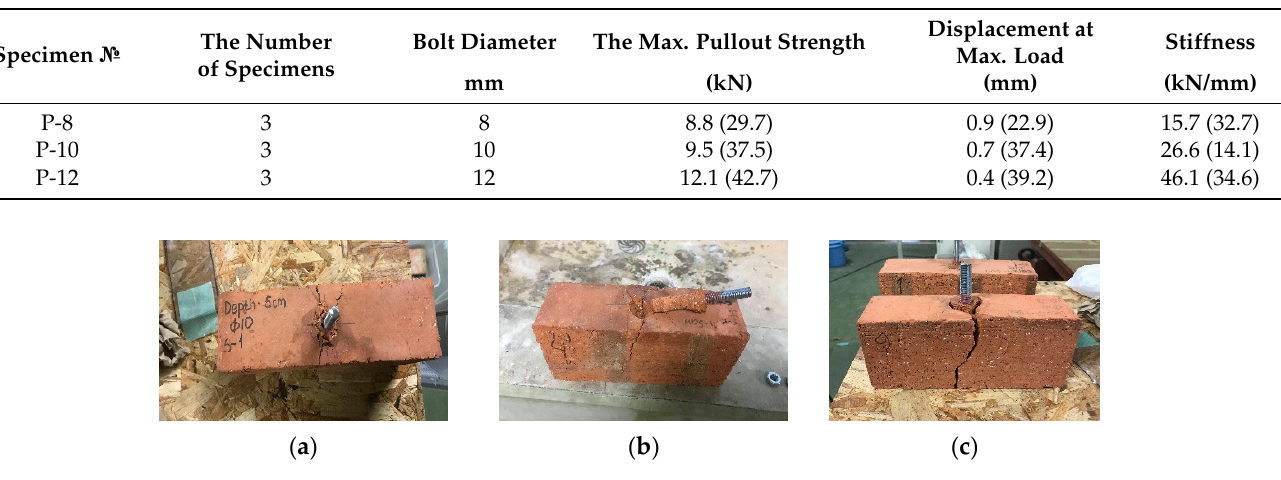
Figure 9. Pullout failure on the bricks. ( a ) P-8-1 specimen; ( b ) P-10-1 specimen; ( c ) P-12-3 specimen.